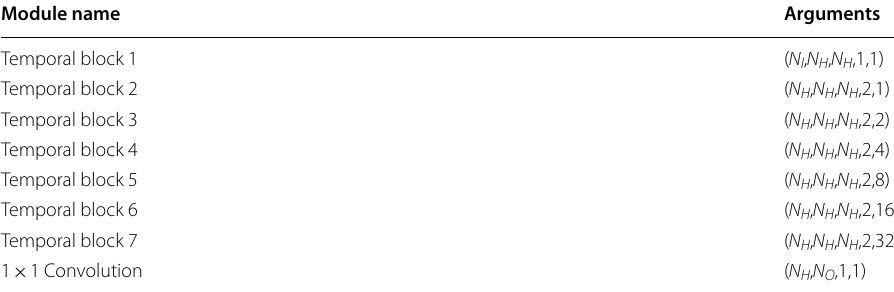
Table 8 The TCN architecture of the models